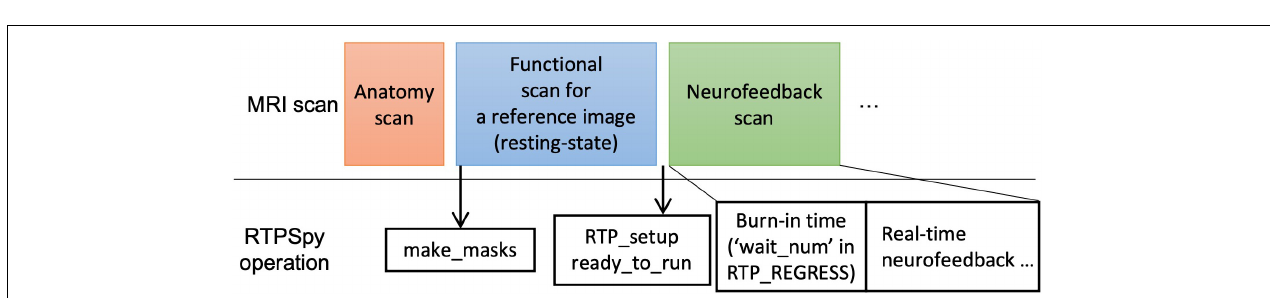
FIGURE 6 | A snippet of an example script to run a real-time processing pipeline using RTP_APP interfaces. The comments with bold alphabet indicate a part of the script explained in the main text. Instantiating the RTP_APP class (A) creates all processing modules inside it. If you use the “ make_masks ” method to create the mask images, call the method of the rtp_app instance (B) . This example uses dummy physiological signals (C) . The module properties can be set directly by accessing the “ rtp_app.rtp_obj ” property (C) or by feeding a property dictionary to the “ rtp_app.RTP_setup ” method (D,F) . If physiological signals are not available, you can disable RETROICOR by setting the “ phys_reg ” property of “ REGRESS ” to “ None ” (E) . Calling the “ rtp_app.ready_to_run ” initializes the pipeline (G) . The processing can be started by calling the “ manual_start ” method (H) . To close the pipeline, call the “ end_run ” method (I) .